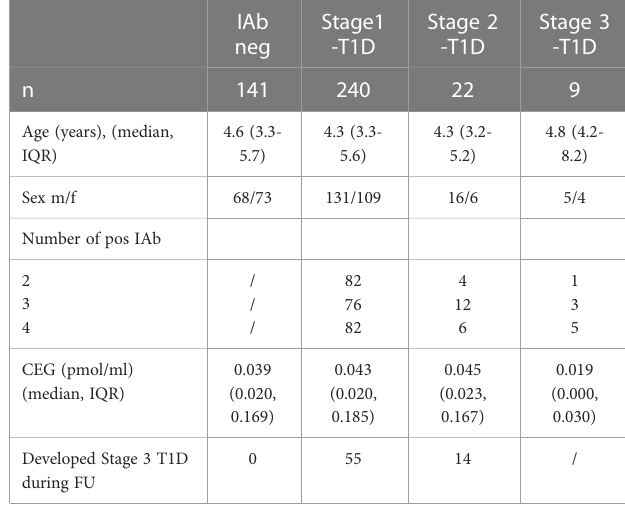
TABLE 1 Characteristics of study